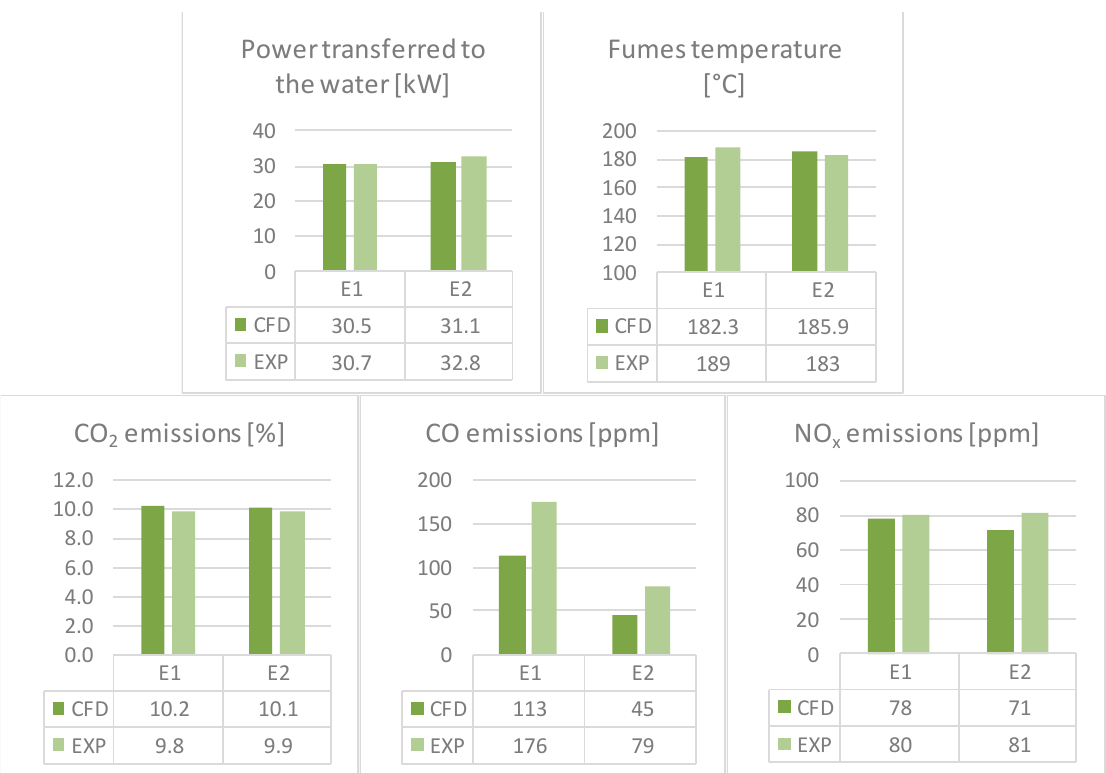
Figure 6. Experimental results vs. model prediction.